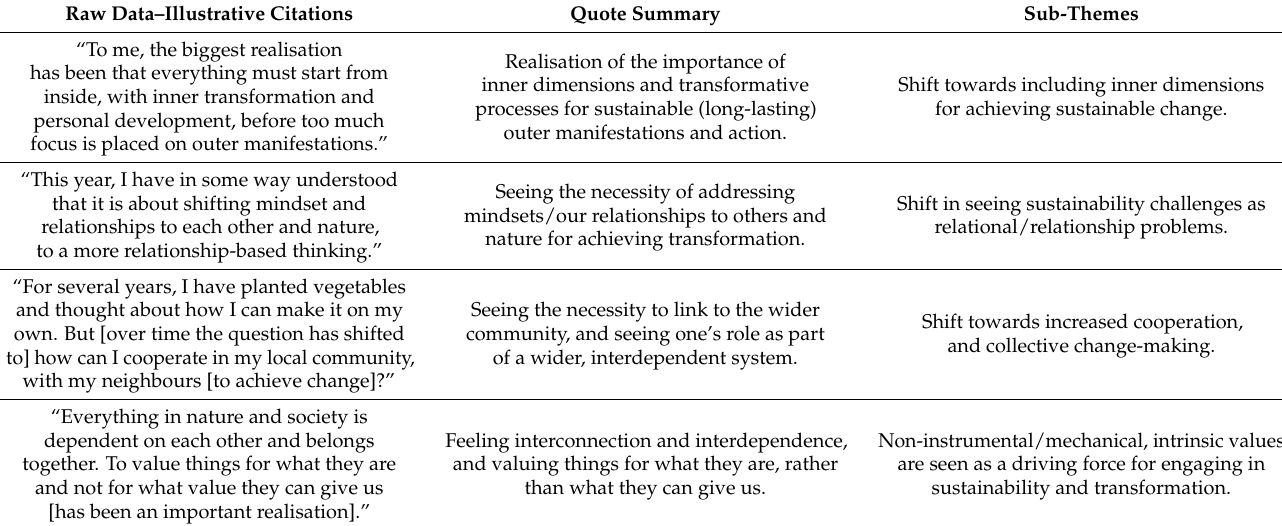
Table 1. Theme 1–Relational and interconnected perspectives.